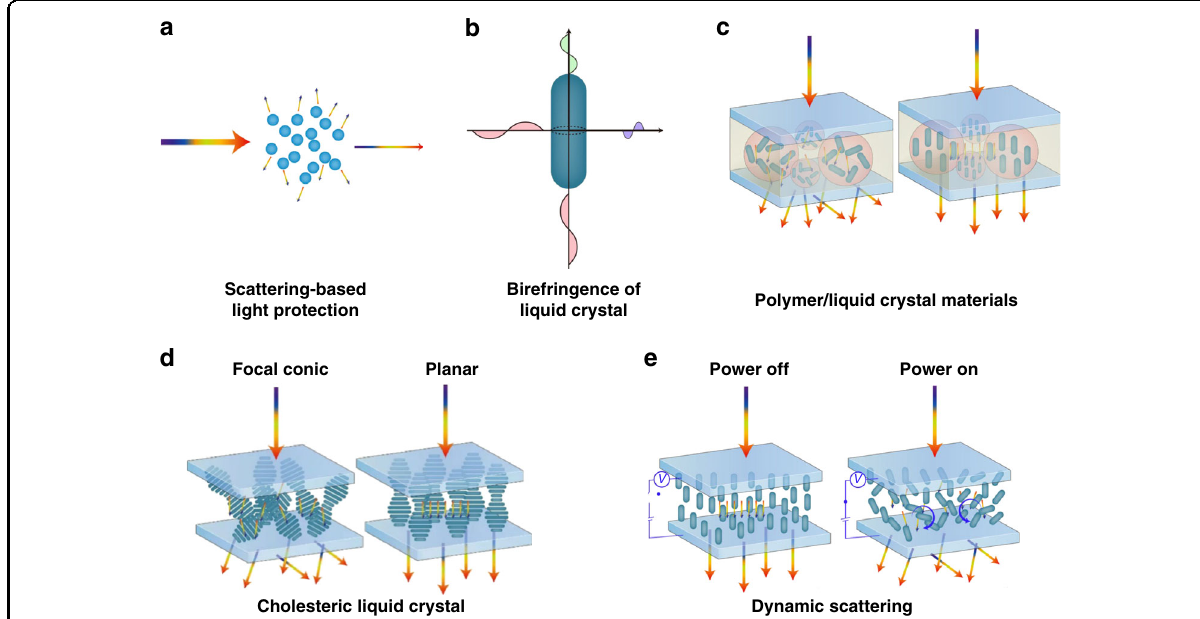
Fig. 9 Scattering-based light protection principles. a Scattering principle for light protection. b Birefringence of liquid crystal molecules. c Scattering properties of polymer-liquid crystals (P-LCs). d Scattering properties of CLC. e Dynamic LC scattering